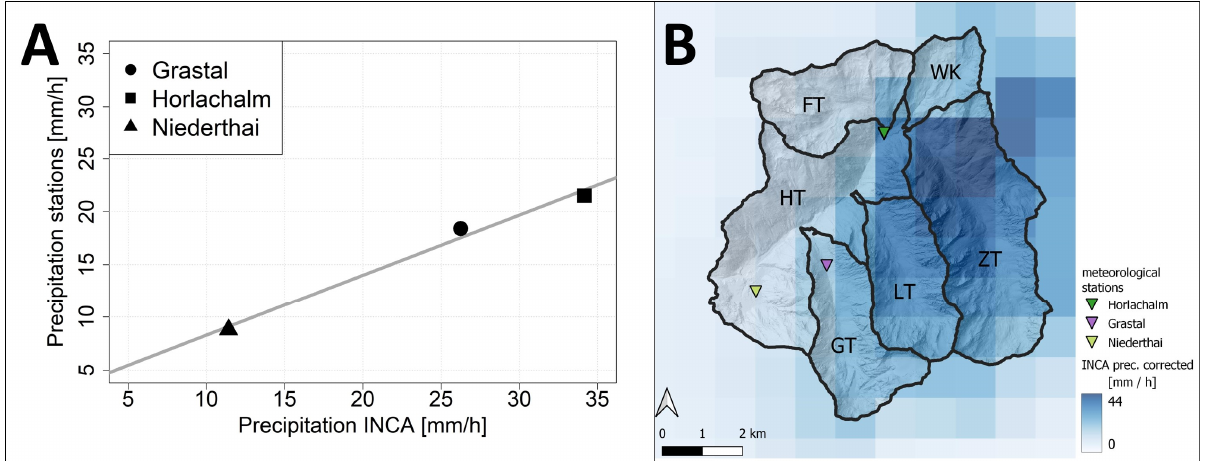
Figure 7. A: Relationship between the precipitation measurements at the meteorological stations and the INCA rainfall data for the event on 20 July 2022, from 4 pm to 5 pm. B: Gridded INCA data with corrected absolute precipitation values for the same timeframe.